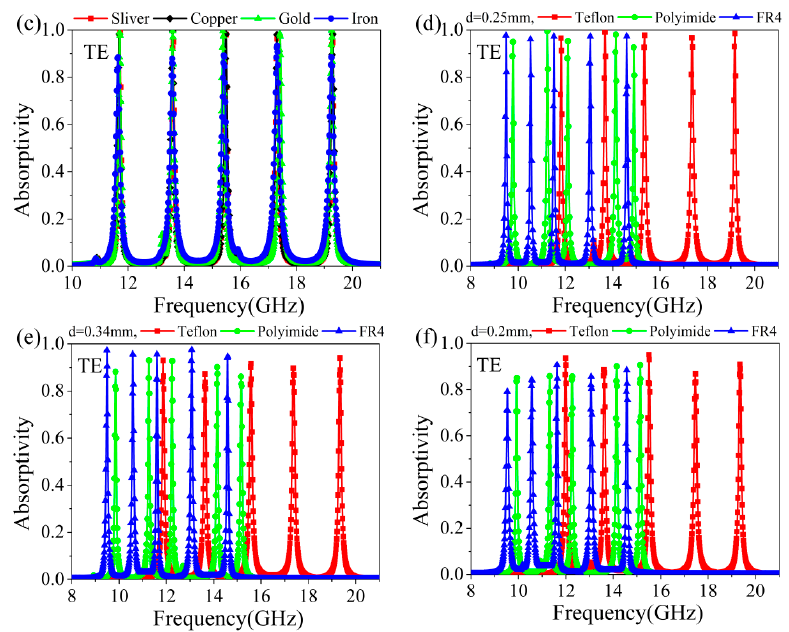
Figure 4. The absorptivity for different wire lengths ( a ) l 2 and ( b ) l 3 , ( c ) for different metals, ( d ), ( e ) and ( f ) for different dielectric materials with different thickness.